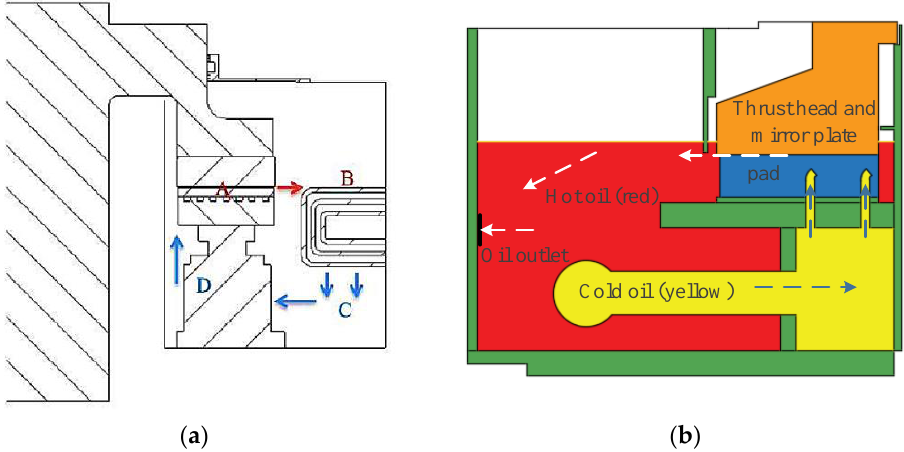
Figure 13. Oil flow path of internal circulation and external circulation cooling. ( a ) Internal circulation cooling oil flow path [41]; ( b ) external circulation cooling of the external pump oil flow path.